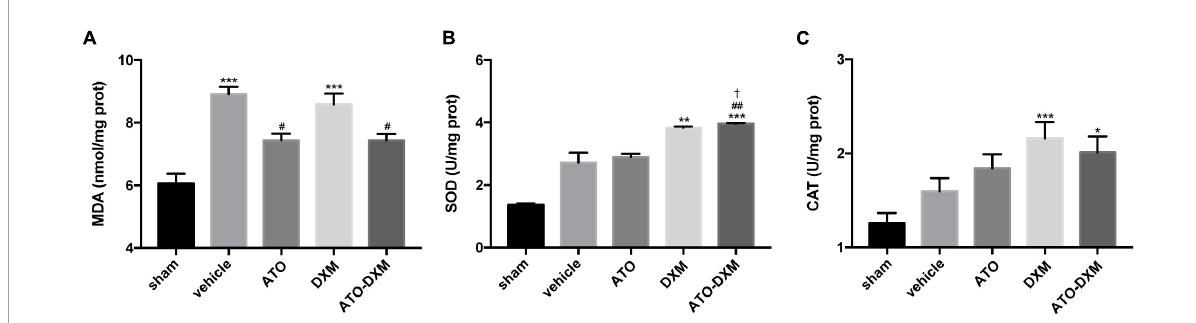
FIGURE7 Assessment of oxidative and antioxidative capacities of the tissue surrounding the hematoma on day 3 after ICH. (A) MDA content. (B) SOD activity. (C) CAT activity. * p < 0.05, ** p < 0.01, *** p < 0.001 vs sham group; # p < 0.05, ## p < 0.01 vs vehicle group; † p < 0.05 vs ATO group.